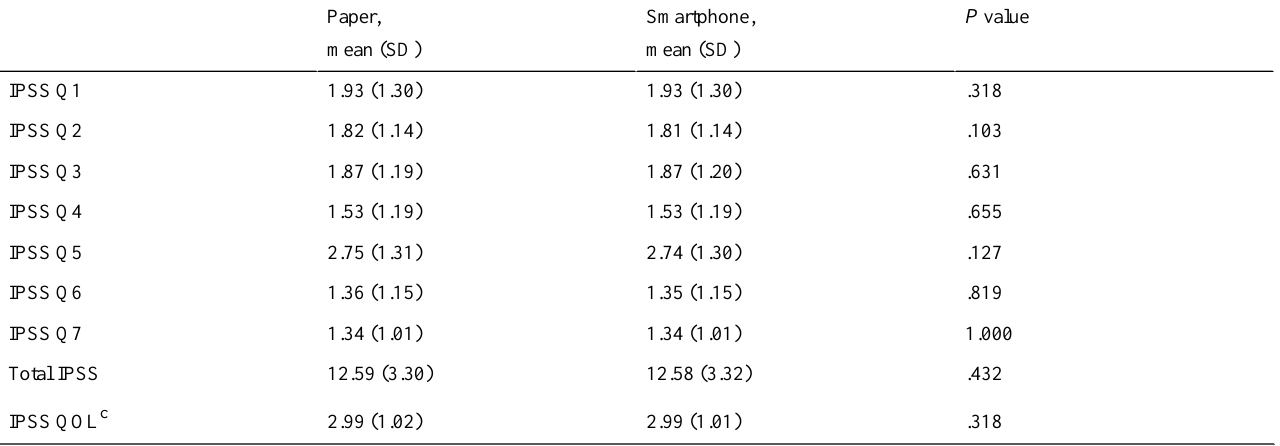
Table 4. Paired t test between paper and smartphone IPSS a in moderate LUTS b .